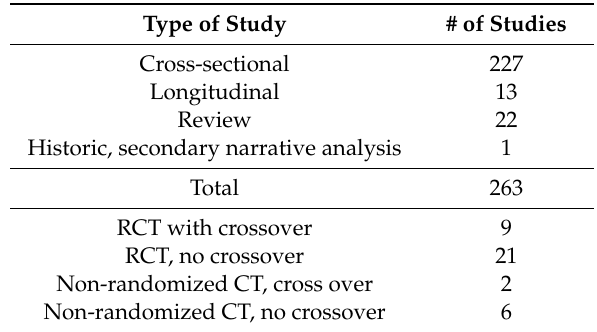
Table 3. The included studies were divided into groups based on their study design (some papers are represented in more than one group, i.e., a cross-sectional study with an RCT design). Type of Study